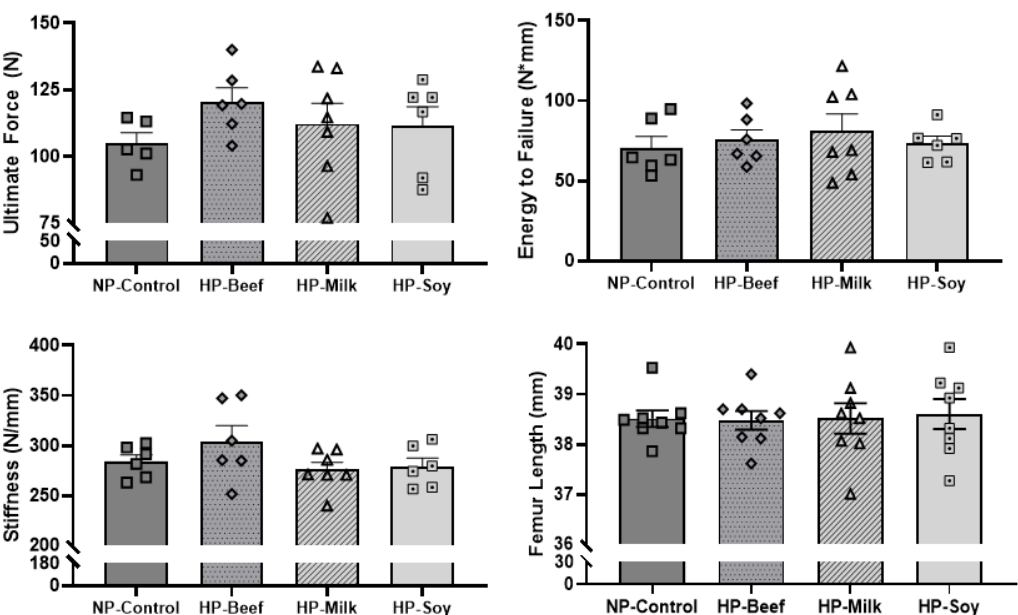
Figure 5. Mechanical properties of 32-week-old femurs from post-menopausal rodents following 12 weeks of energy restriction. Mean ± SEM; One-way ANOVA was performed. The main effects of WL and diet on dynamic and static histomorphometry measure- ments are shown in Table 6. Relative to baseline, endocortical BFR/BS increased following WL (main effect of WL, p = 0.016), with subsequent post-hoc analyses revealing only the HP-beef diet increased endocortical BFR/BS following ER ( p = 0.032). Endocortical MS/BS appeared to increase with WL (main effect of WL, p = 0.019) and be influenced by diet ( p = 0.047); however, subsequent post-hoc analyses revealed only trends for these effects. The NP diet and HP-beef diet showed trends for greater endocortical MS/BS versus base- line (NP diet, p = 0.073; HP-beef diet, p = 0.068) and the HP-soy diet showed trends for lower endocortical MS/BS versus NP diet ( p = 0.099) and HP-beef diet ( p = 0.093). Neither WL nor diet influenced other measurements of bone formation. Table 6. Bone histomorphometry measurements following 12 weeks of energy restriction 1 . Baseline NP-Control HP-Beef HP-Milk HP-Soy Significance 2 Weight Loss